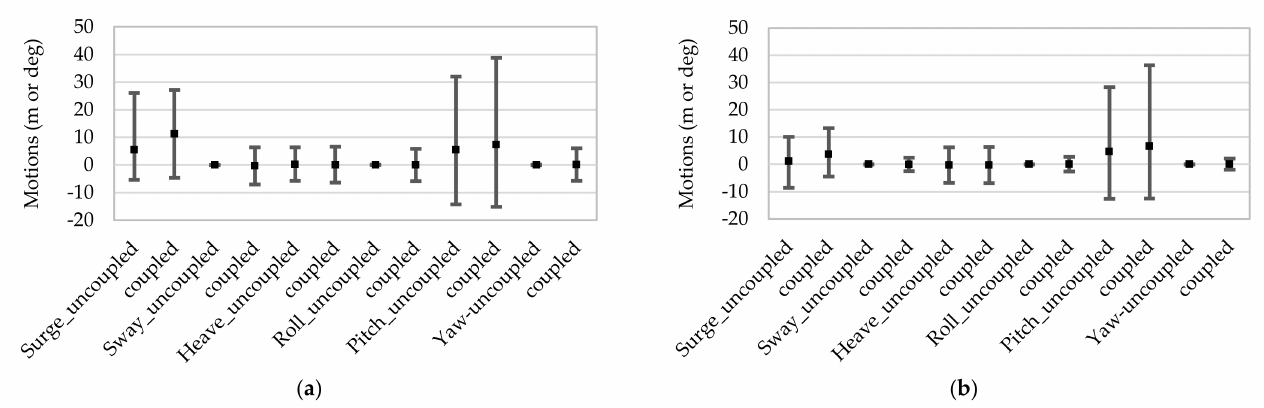
Figure 8. Mooring buoy motions for the uncoupled and coupled cases for 50 yr and heading 0 deg (Whisker = max and min, marker = mean): ( a ) pretention option A; ( b ) pretention option